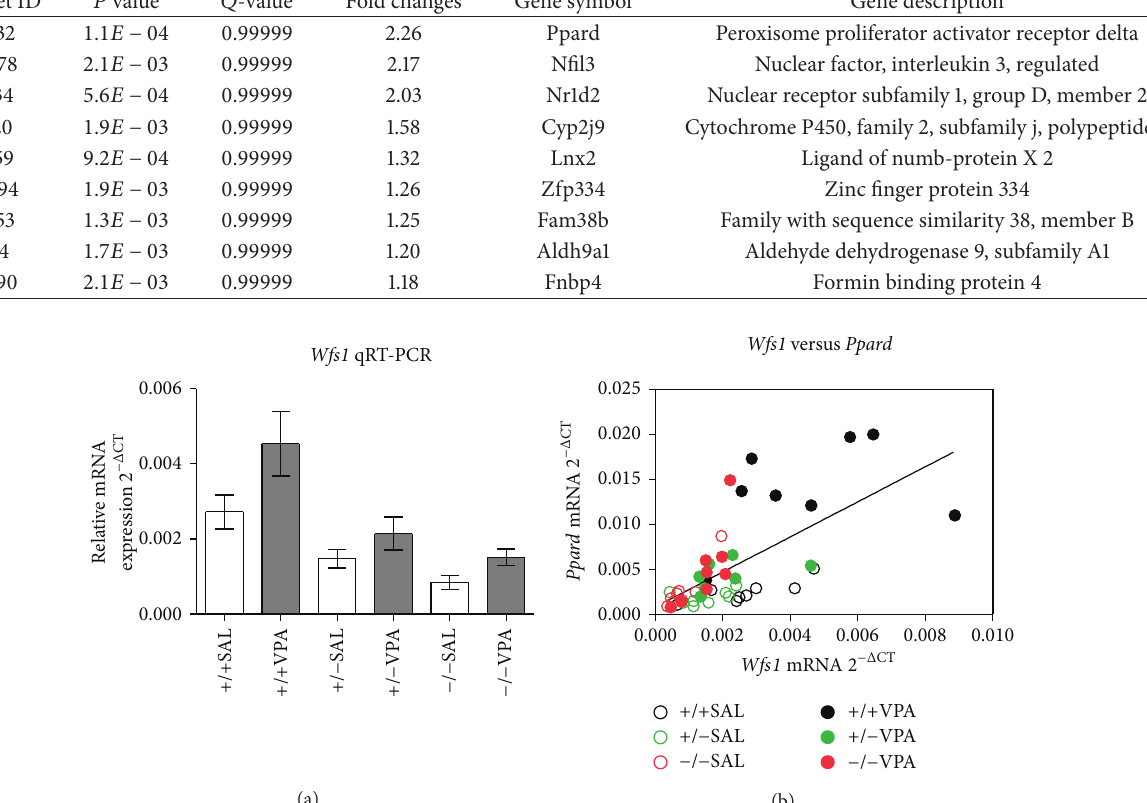
VPA seems to impair glucose tolerance of Wfs1 KO mice, contrary to its acute